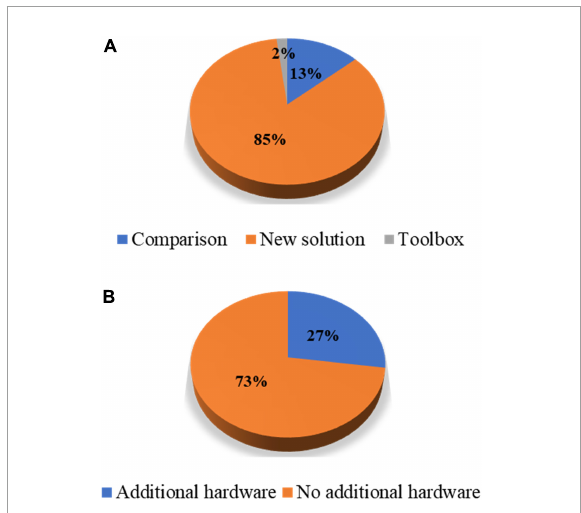
FIGURE1 Percentage partitions: (A) Article types of the selected papers and (B) hardware-based solutions against algorithmic solutions among the papers proposing new